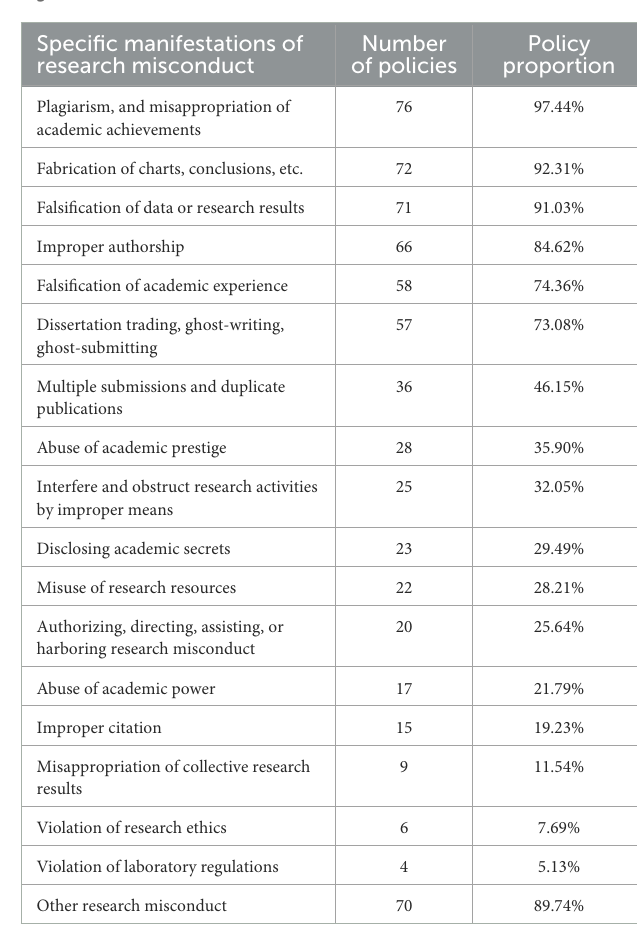
TABLE 2 Specific manifestations of research misconduct in the RI policy of higher education